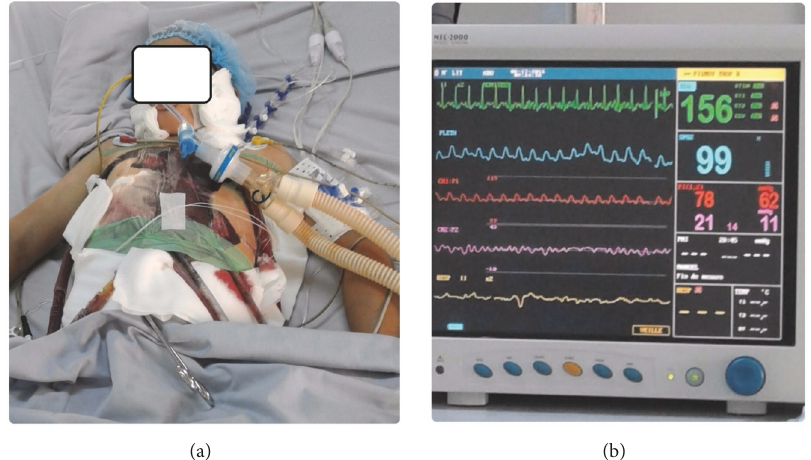
Figure 2: (a) Postoperative view of the central venoarterial ECMO in the patient. (b) Hemodynamic status monitoring under ECMO with pulsatile arterial